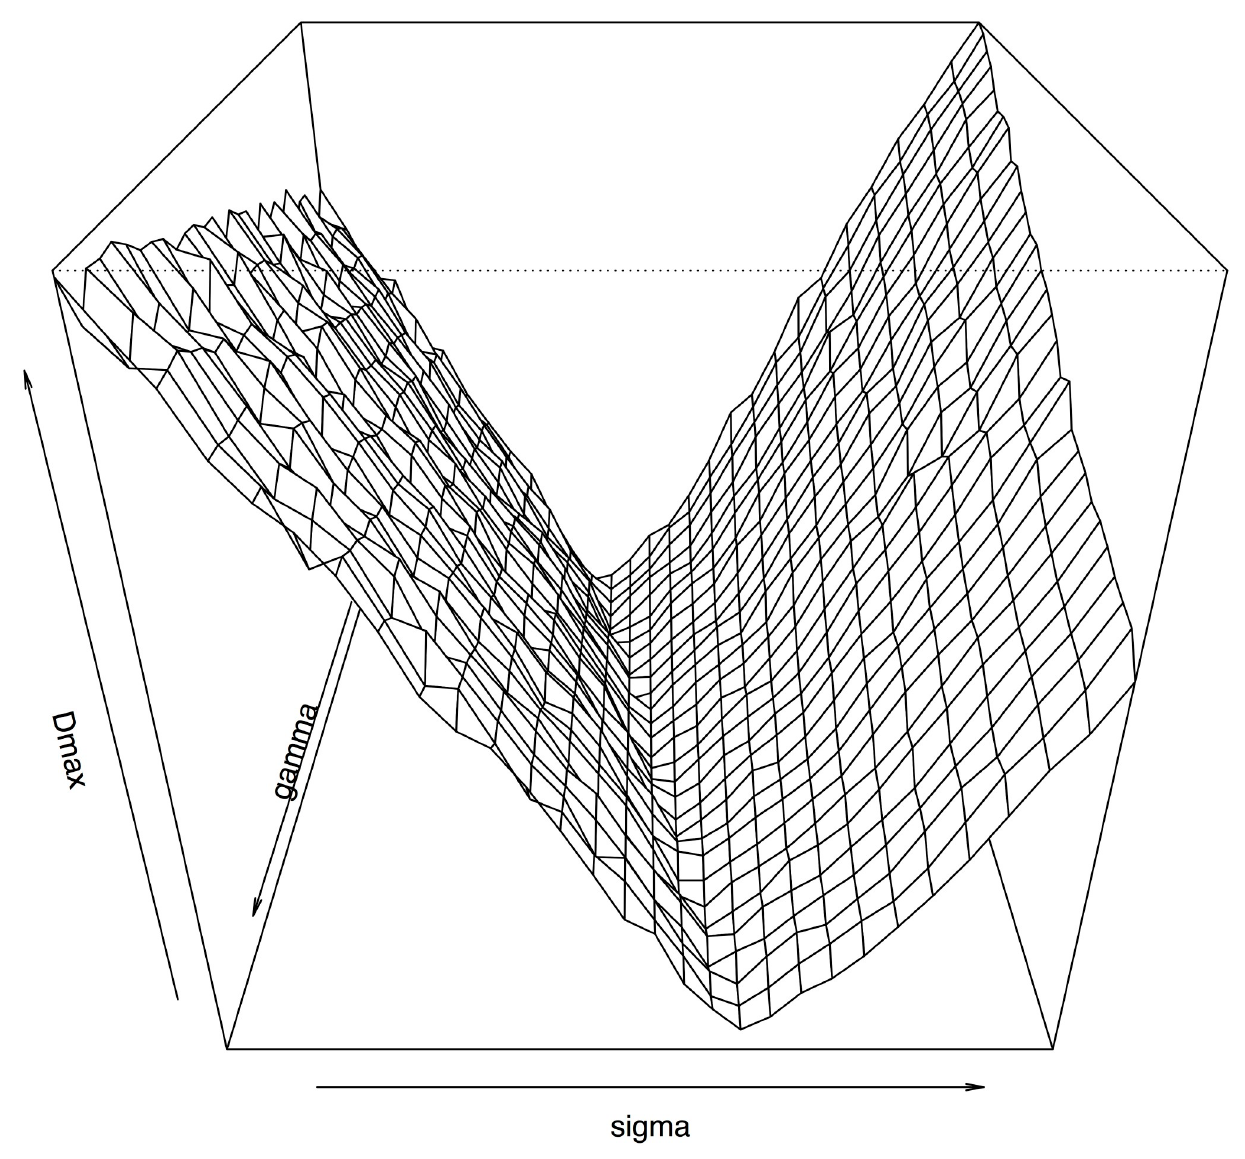
Fig 5. Optimal estimates of ( σ , γ